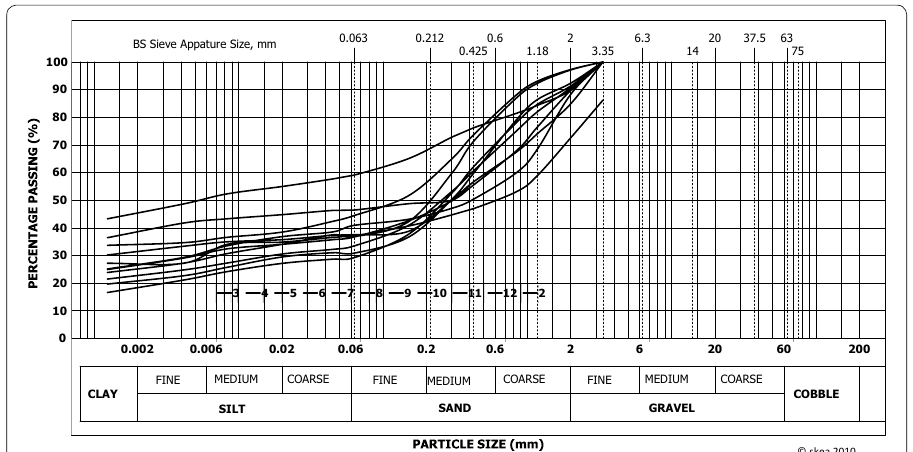
Fig. 4 Grain size distribution curves for samples 1–12